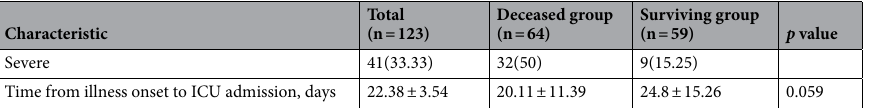
Table 1. Clinical characteristics of intensive care COVID-19 patients. Data are presented as mean ± SD or number (%). COPD, chronic obstructive pulmonary disease; ICU, intensive care unit; NLR, neutrophil– lymphocyte ratio; ALT, alanine aminotransferase; AST, aspartate transaminase; A/G ratio, white/globule ratio; BNP, brain natriuretic peptide; APTT, activated partial thromboplastin time; LDH, lactate dehydrogenase;